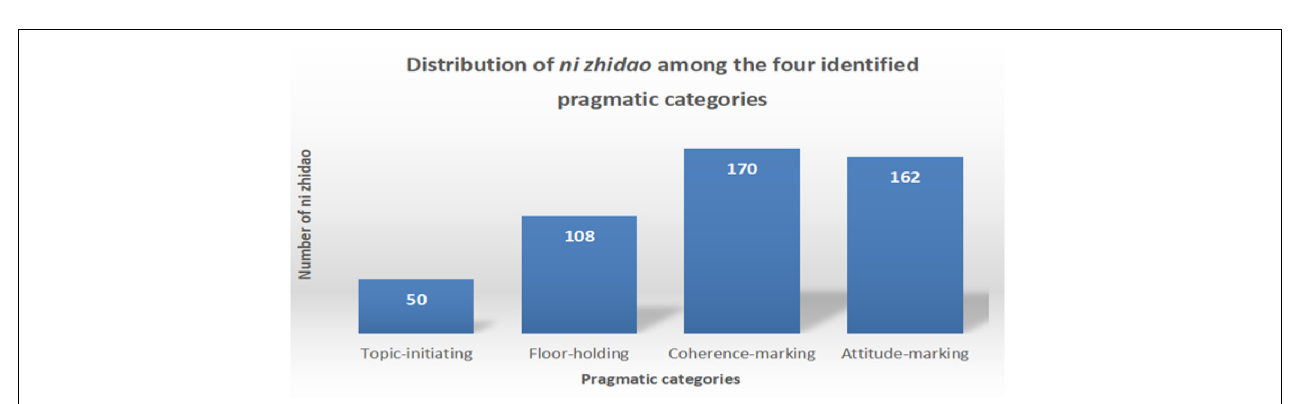
FIGURE 10 | Praat analysis of sentence-final ni zhidao.